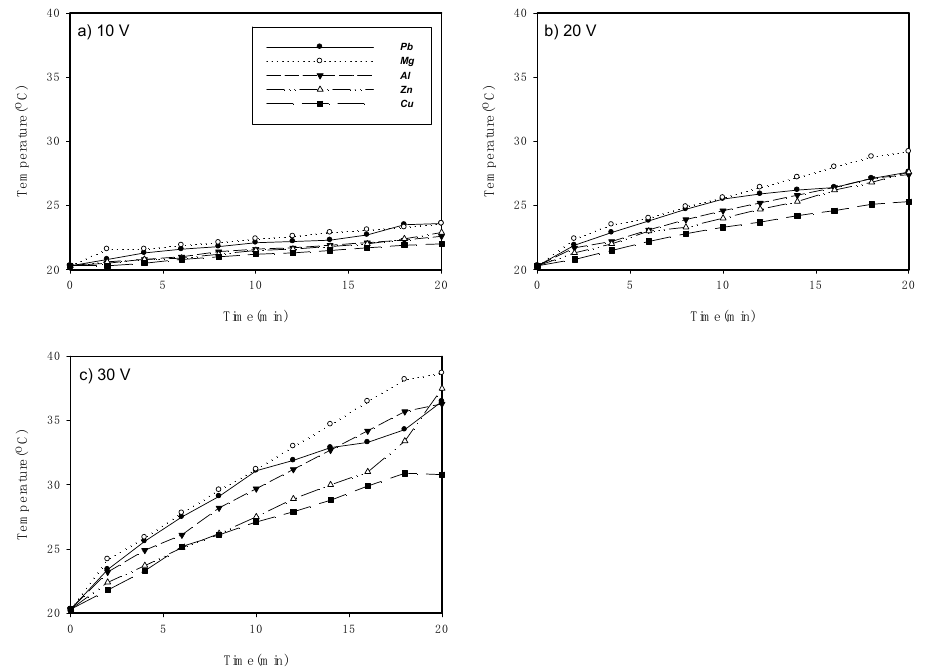
Figure 5. Temperature changes in the supernatants during electrocoagulation at ( a ) 10 V, ( b ) 20 V, and ( c ) 30 V.